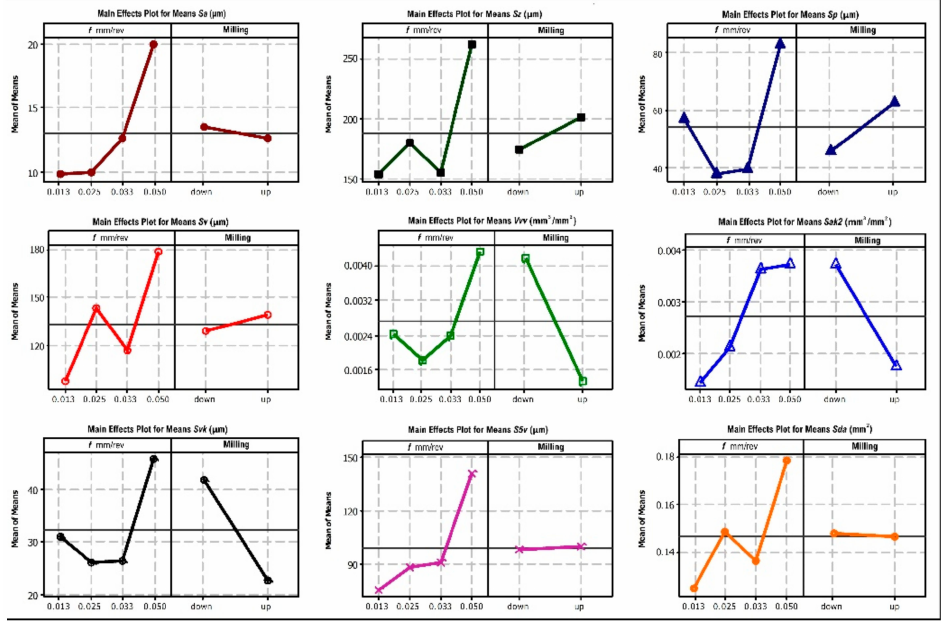
Figure 8. Influence of cutting data on the parameters Sa ( µ m), Sz ( µ m), Sp ( µ m), Sv ( µ m), Vvv (mm 3 /mm 2 ), Sak2 (mm 3 /mm 2 ), Svk ( µ m), S5v ( µ m), Sda (mm 2